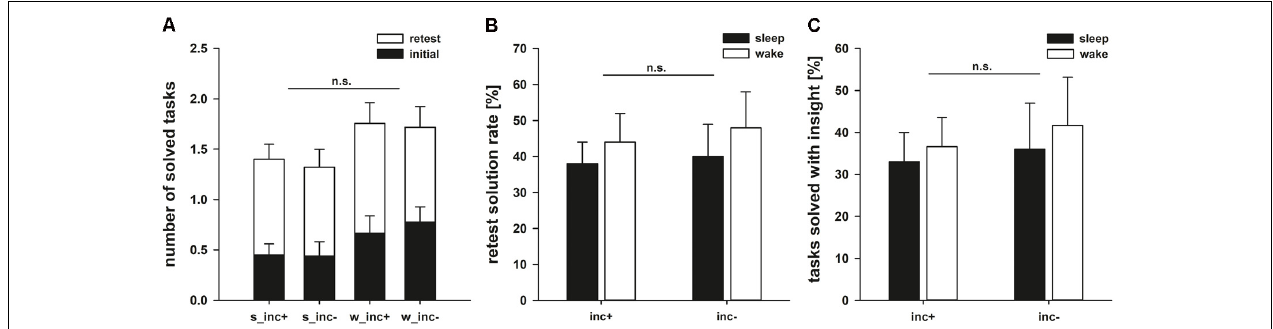
FIGURE 4 | (A) Performance after the first (black bars) and the second (white bars) encounters. Note that the maximum number of tricks to be solved was 3. (B) Retest solution rates. As the insight tasks were not presented again when they had been solved in the initial phase, 100% represents having solved all remaining insight tasks. (C) Percentage of tasks that were solved with insight. TABLE 6 | Correlations between memory performance measures and specific sleep stages in s_inc + . S1 S2 SWS REM TST a Wake Retest solution rates of the classical problems r 0.477 − 0.307 −